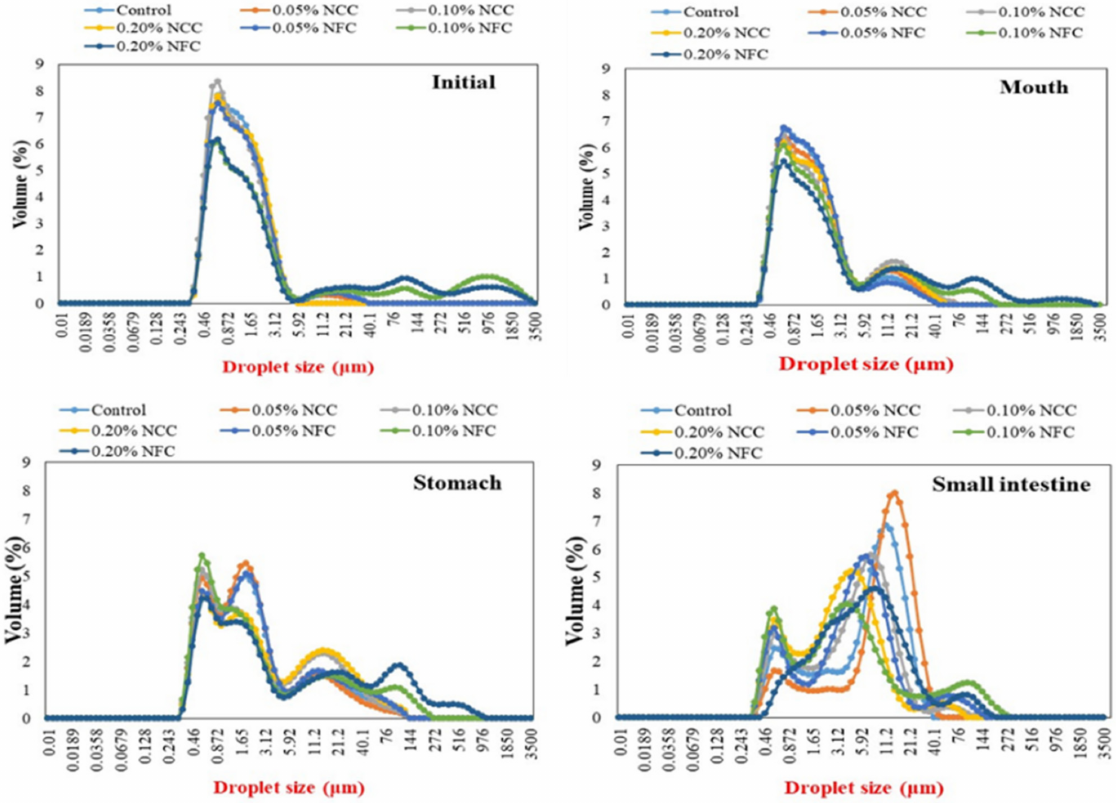
Figure 4. Influence of nanocellulose and gastrointestinal tract (GIT) stage on particle size distribution of 10% ( w / w ) O/W emulsions containing β